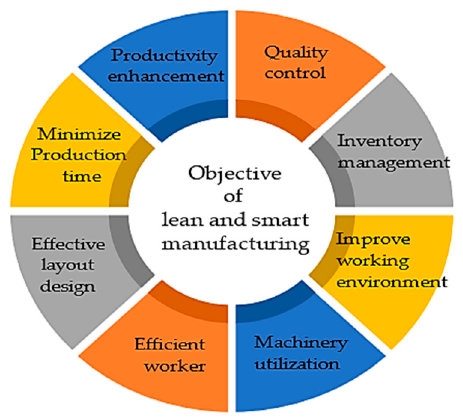
Figure 1. Objective of lean and smart manufacturing.